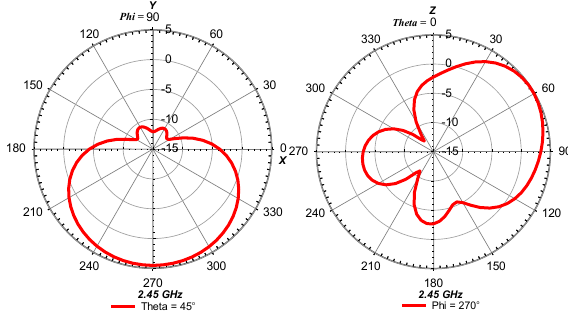
Figure 10: Example of simulated radiation patterns of the RFSR antenna.